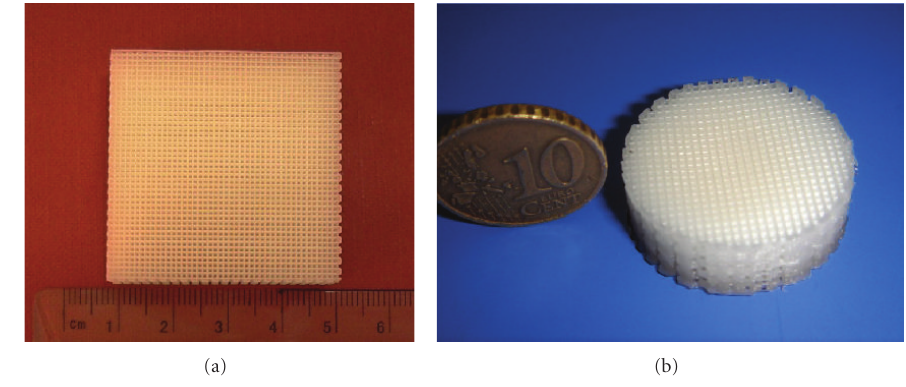
Figure 3: Square and disc shape sca ff olds produced by the BioExtruder.